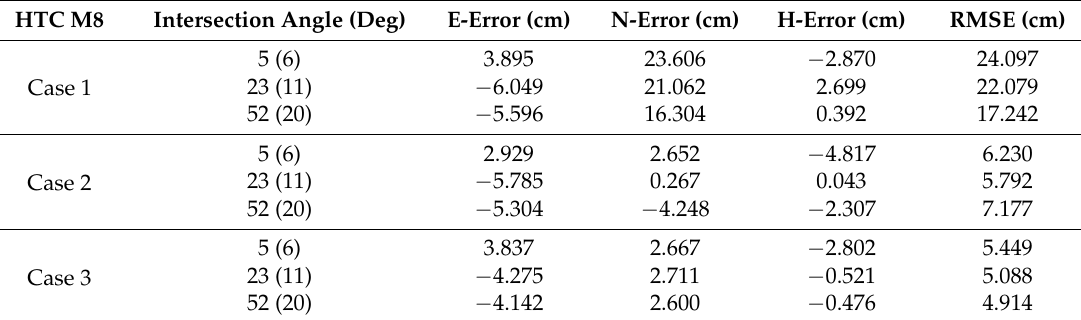
Table 3. The position error of intersection angle analysis for the HTC